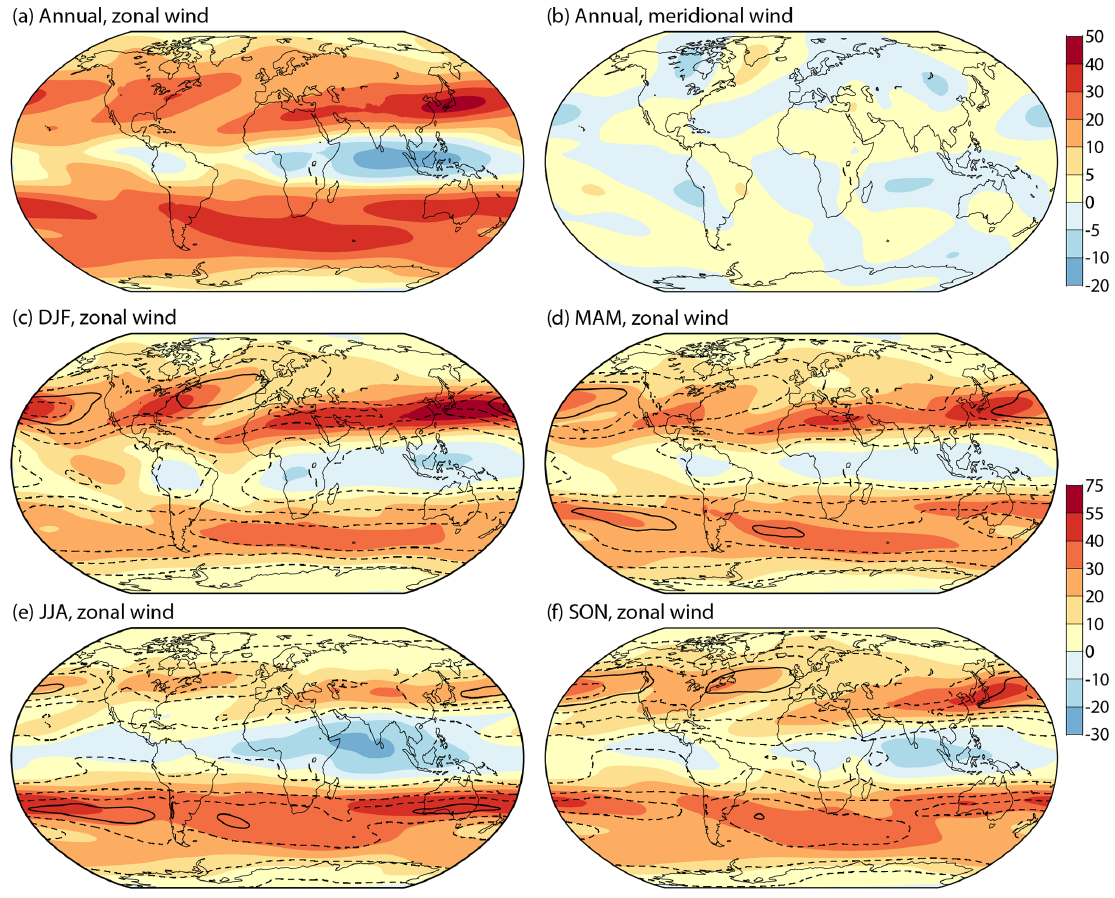
Figure 6. ERA5 200hPa wind (ms − 1 ) averaged from March 1979 to February 2022 for (a) the zonal and (b) the meridional component. Seasonal-average zonal components for this period are shown (with different contour intervals) in panels (c) DJF, (d) MAM, (e) JJA and (f) SON. Black contours show the total variation of the 200hPa wind vector, with a contour interval of 160m 2 s − 2 . Solid contours denote the 600m 2 s − 2